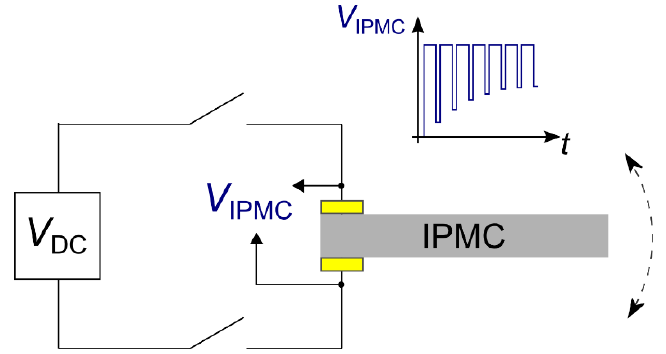
Figure 10. Self-sensing IPMC proposed by Ko et al.